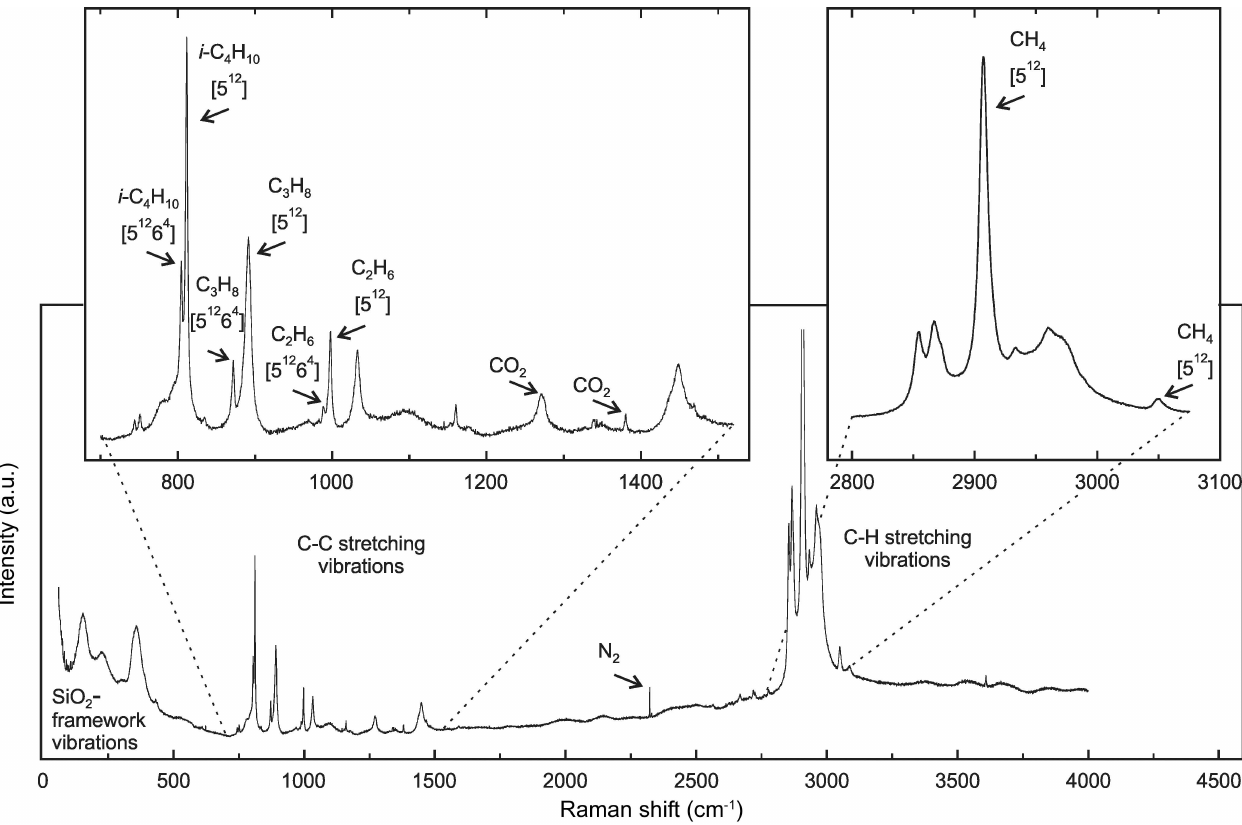
Figure 1 Raman spectrum of chibaite under ambient conditions. The two inserts represent the enlarged cut-outs of 700–1500 cm (cid:4) 1 and 2800–3100 cm (cid:4) 1 containing the hydrocarbon C—C and C—H stretching vibrations. The labeling of the allocated major bands corresponds to the respective molecule and the cage types (see Table 2) (Sum et al. , 1997; Charlou et al. , 2004; Tribaudino et al. , 2008; Klapp et al. , 2010; Momma et al. , 2011; Likhacheva et al. ,